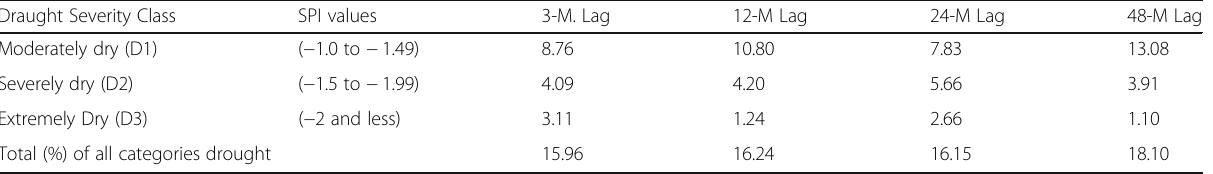
Table 6 Drought occurrences (%) in GWB at corresponding drought categories and time steps Draught Severity Class SPI values